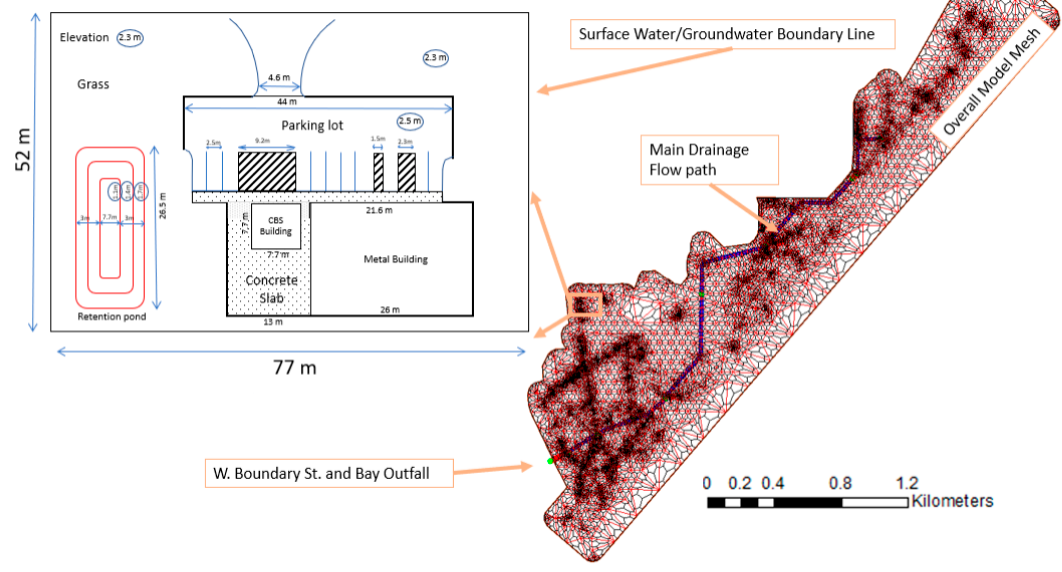
Figure 5. Groundwater / surface water computational meshes for model domain (left) and project site (right).